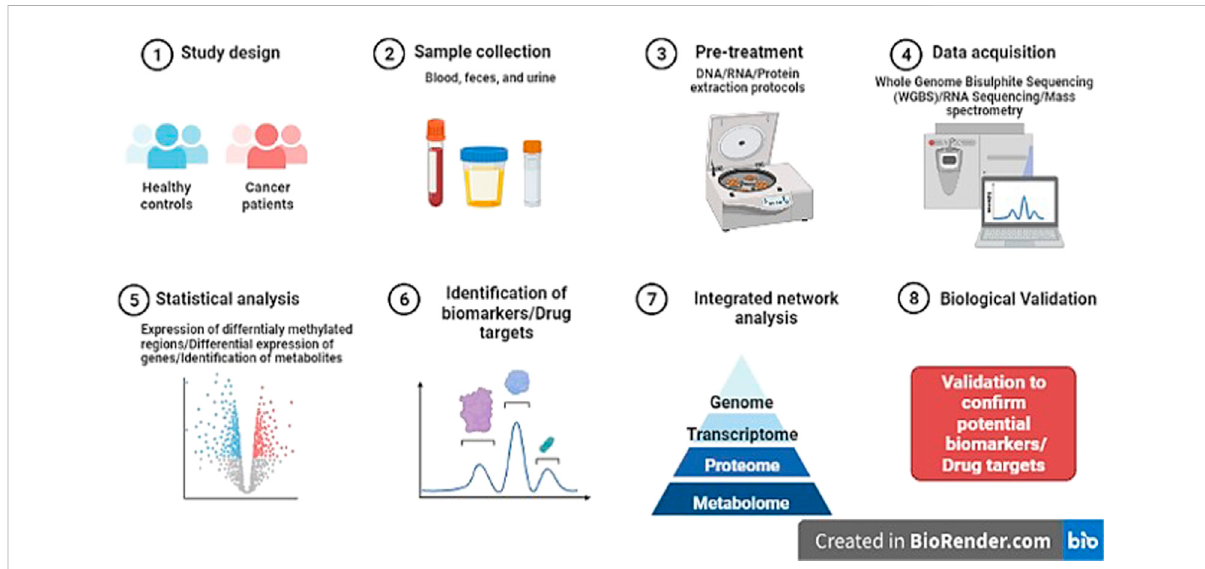
FIGURE 5 Diagrammatic representation of research pipeline on the discovery of novel potential epi-markers in human cancers (Templatewas created by free